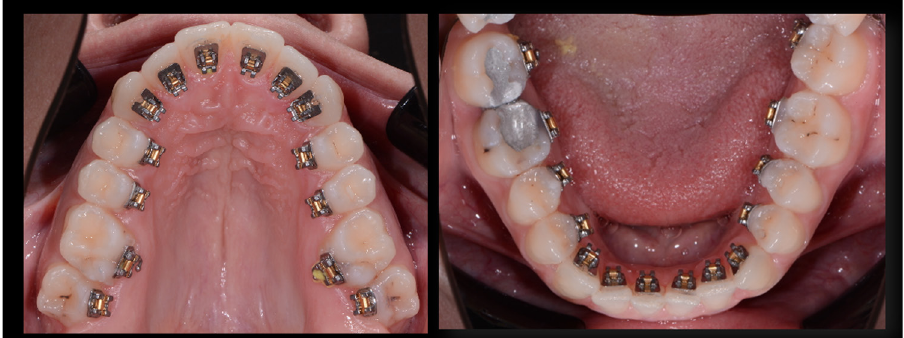
Figure 4. Self-ligating lingual brackets after indirect